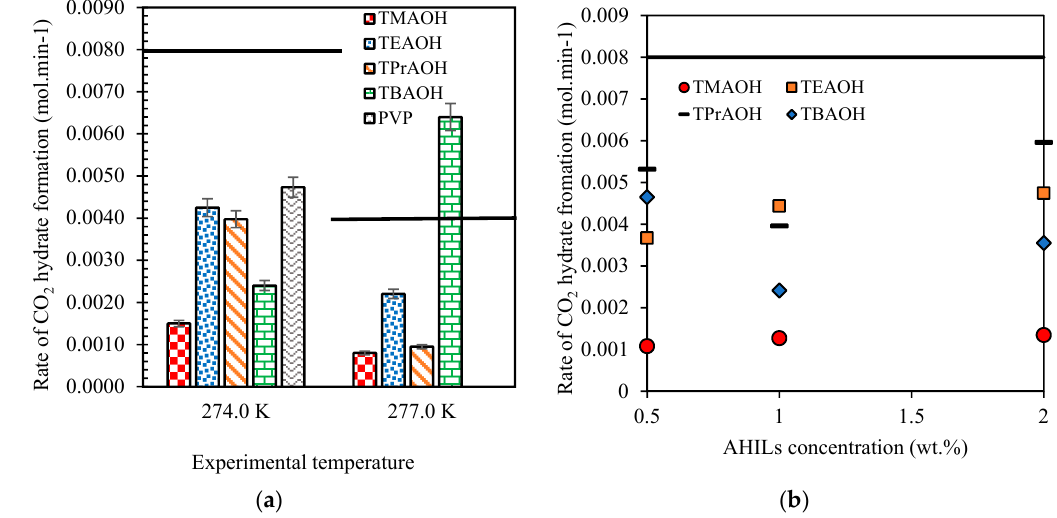
Figure 6. ( a ) Effect of AHILs on the measured CO 2 hydrate initial rate of formation at different experimental temperatures at 1 wt.%; ( b ) Effect of AHILs concentrations on the CO 2 hydrate initial rate of formation at 274.15 K; The black line symbolizes pure water values; No hydrate formation was observed for PVP at 277.0 K.